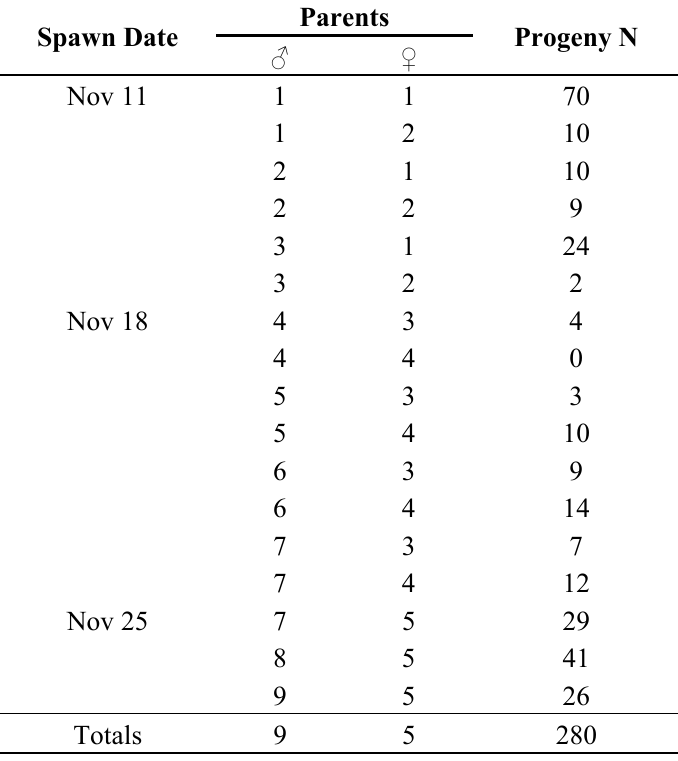
Table 7. Mating structure of wild Sakinaw Lake sockeye salmon parents in P2002 according to hatchery records and numbers of F progeny assigned to parents by maximum 1 likelihood analysis of progeny genotypes. The progeny were reared in the captive breeding program and spawned at Rosewall hatchery in 2005 and